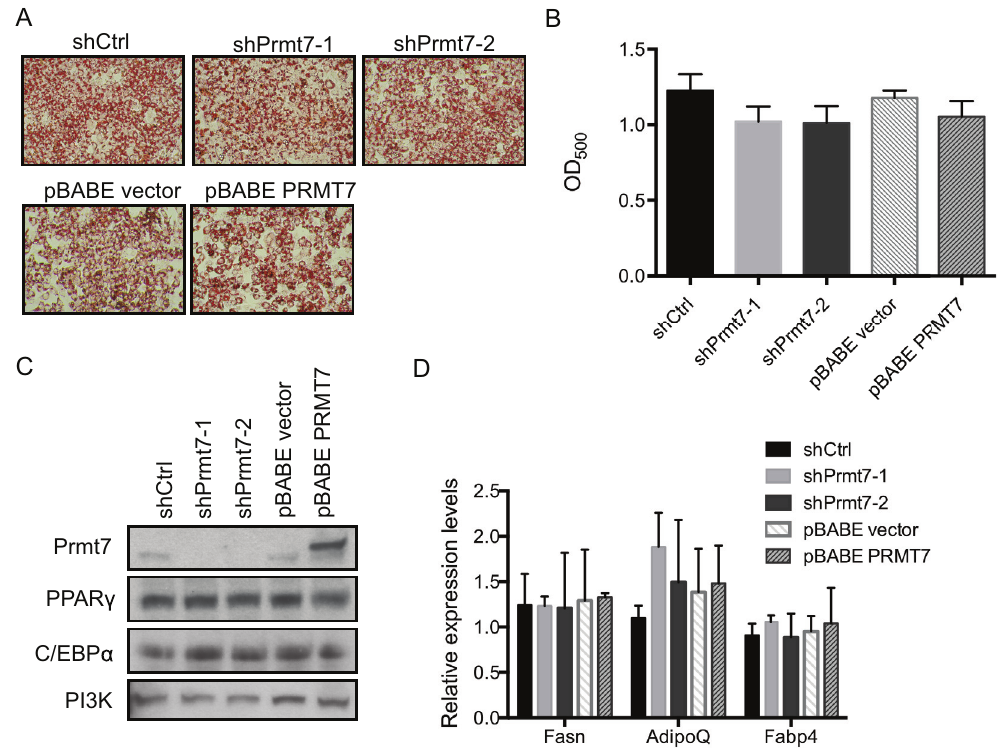
Figure 4. Knockdown or over-expression of Prmt7 has no effect on C3H10T1/2 adipogenic differentiation. ( A ) Representative Oil-Red O staining images of day 6 post-differentiated C3H10T1/2 cells in which Prmt7 was either knocked down (shPrmt7-1 and shPrmt7-2) or over- expressed (pBABE PRMT7). The Prmt7 knockdown and over-expression C3H10T1/2 cells were grown to confluence and differentiated 48 h later. At day 6 post-differentiation, the cells were fixed with 10% formalin and stained with Oil-Red O. ( B ) The quantification of ( A ). The Oil-Red O stain was extracted with 100% isopropanol and the optical density at 500nm (OD ) was determined. The data represent the average of 500 two independent experiments (n=2) assayed in duplicate. Error bars show standard deviation. ( C ) A representative Western blot analysis of endogenous Prmt7, PPAR γ and C/EBP α expression in day 6 post-differentiated C3H10T1/2 cells. The levels of PI3K are presented as a loading control. ( D ) Gene expression analysis on day 6 post-differentiated C3H10T1/2 cells. The mRNA levels of fatty acid synthase ( Fasn ), adiponectin ( AdipoQ ) and fatty acid binding protein 4 ( Fabp4 ) were measured by RT-qPCR. The individual mRNA levels were normalized to 5S rRNA. The normalized expression levels of the control cells in one of the experiments were set as 1. The data are presented as the average of relative expression levels from two independent experiments (n=2) assayed in duplicate. Error bars show standard deviation. Oil Red O staining. The Oil Red O staining showed similar levels of lipid accumulation in Prmt7 knockdown as well as Prmt7 over- expression cells as compared to the control cells. (Figure 4A and Figure 4B) (Dataset 4). This result suggests that the changes in Prmt7 levels did not affect lipid accumulation in differentiating C3H10T1/2